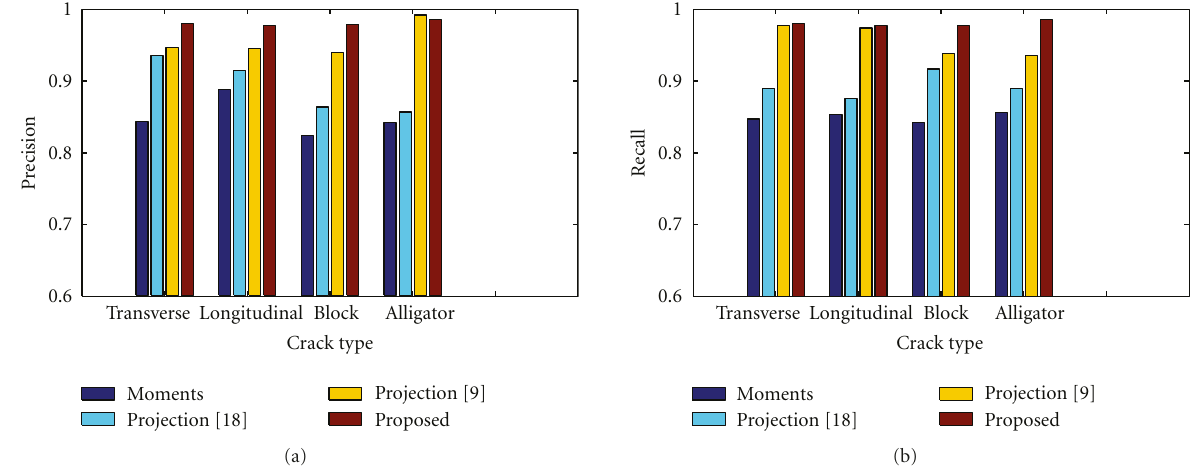
Figure 12: Comparison of the four feature vectors. (a) Comparison on the Precision, (b) comparison on the Recall. Table 2: Comparisons of testing results under di ff erent network